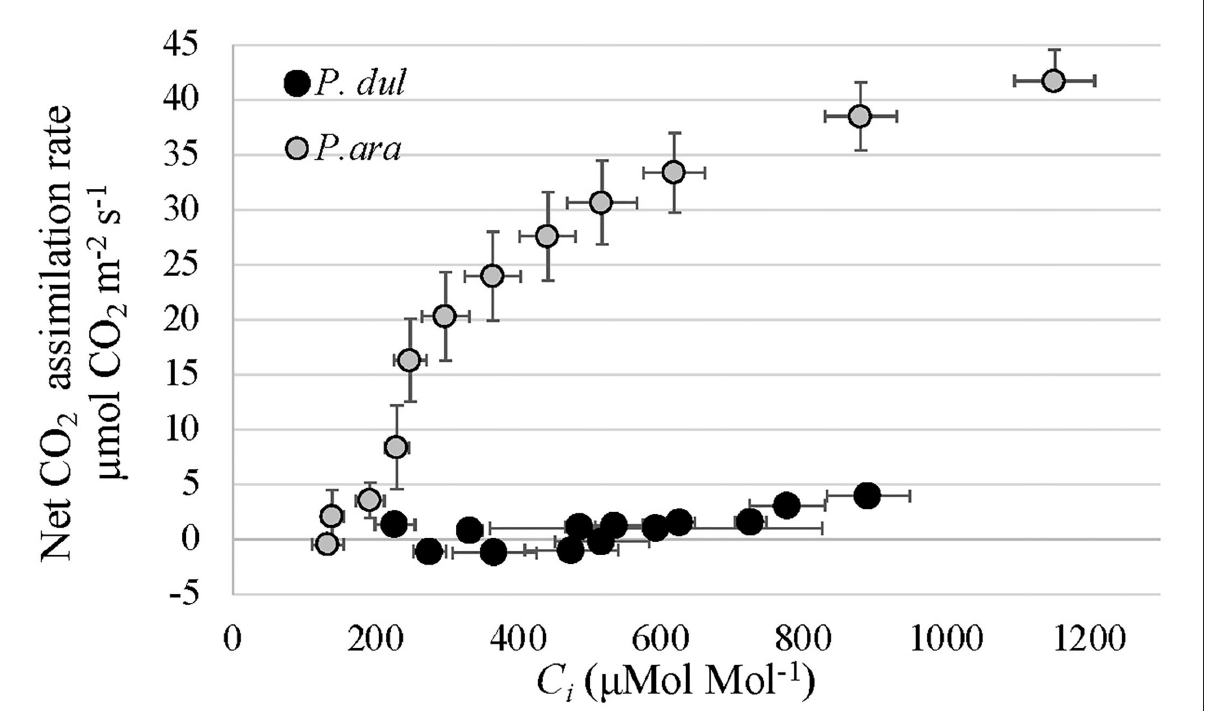
FIGURE7 Response of net CO 2 assimilation ( A n ) to increasing intercellular CO 2 concentration (Ci) in 1 st -year green stems of P. arabica ( P. ara ) and P. dulcis ( P. dul ). Each data point represents mean ± standard errors of 7